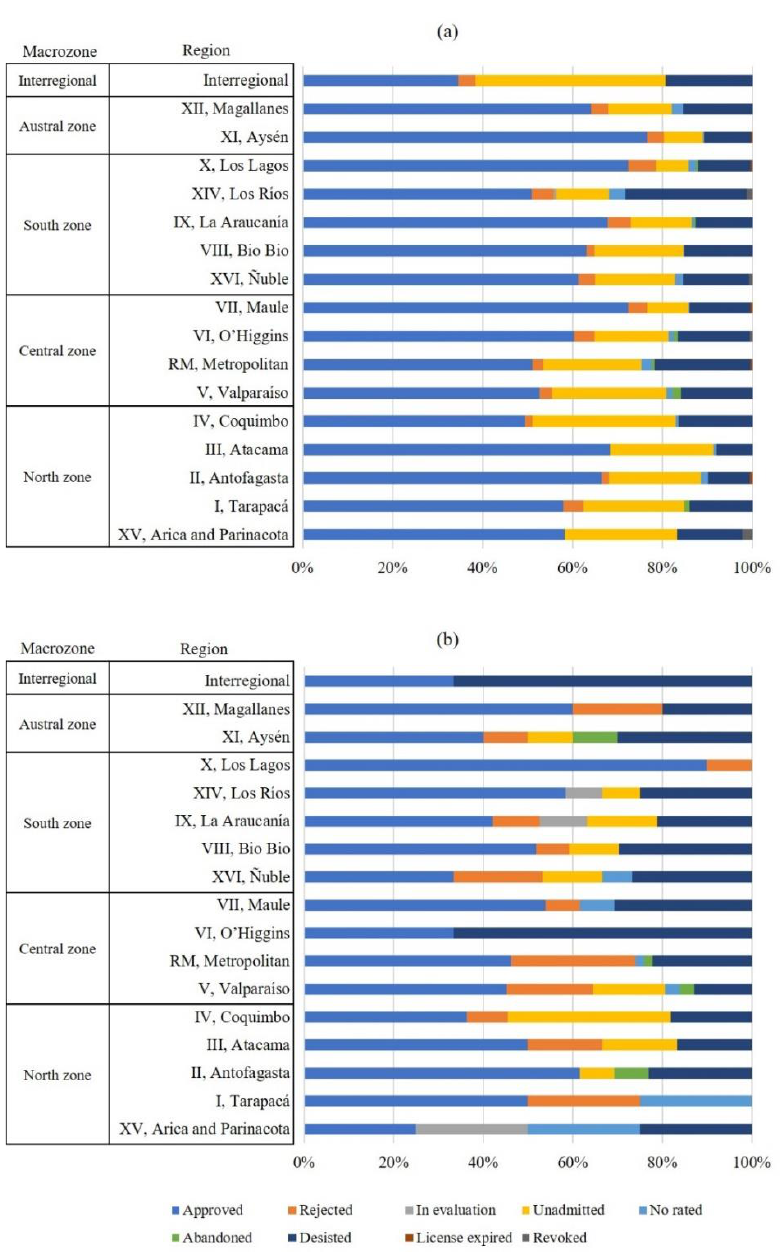
Figure 4. Clustered by regions, percentage of sanitation projects entered as EID ( a ) and EIS ( b ) to the Chilean EIA System. Interregional sanitation projects developed in two or more regions were omitted from the statistical analysis. Full information is included in Table A1 in Appendix A.